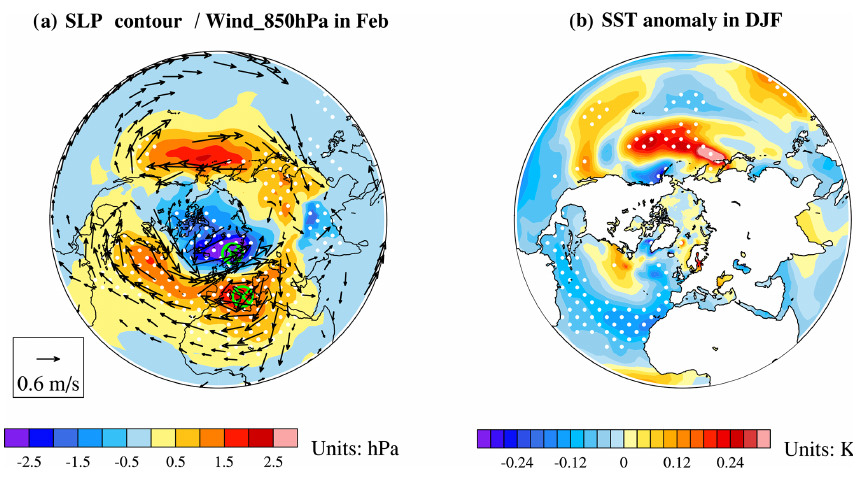
Figure 4. Solar surface signal in NH winter at lag 0 during the strong epoch. Composite differences between the solar maximum and minimum for (a) SLP (contours) and wind at 850hPa (vectors) in February. Only those vectors where the zonal mean wind component is significant at the 90% level are shown. The two green circles indicate the stations used for the NAO index calculation (see “Methods” section for more details). (b) Same as (a) but for SST (contours) averaged over the winter season (DJF). White dots indicate 90% statistically significant regions based on a 1000-fold bootstrapping